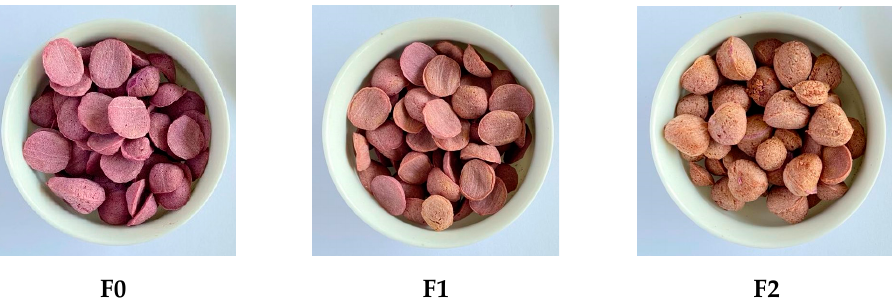
Figure 1. The visual appearance of extruded purple sweet potato with various proportions of kidney bean flour according to the formulation given in Table 1.